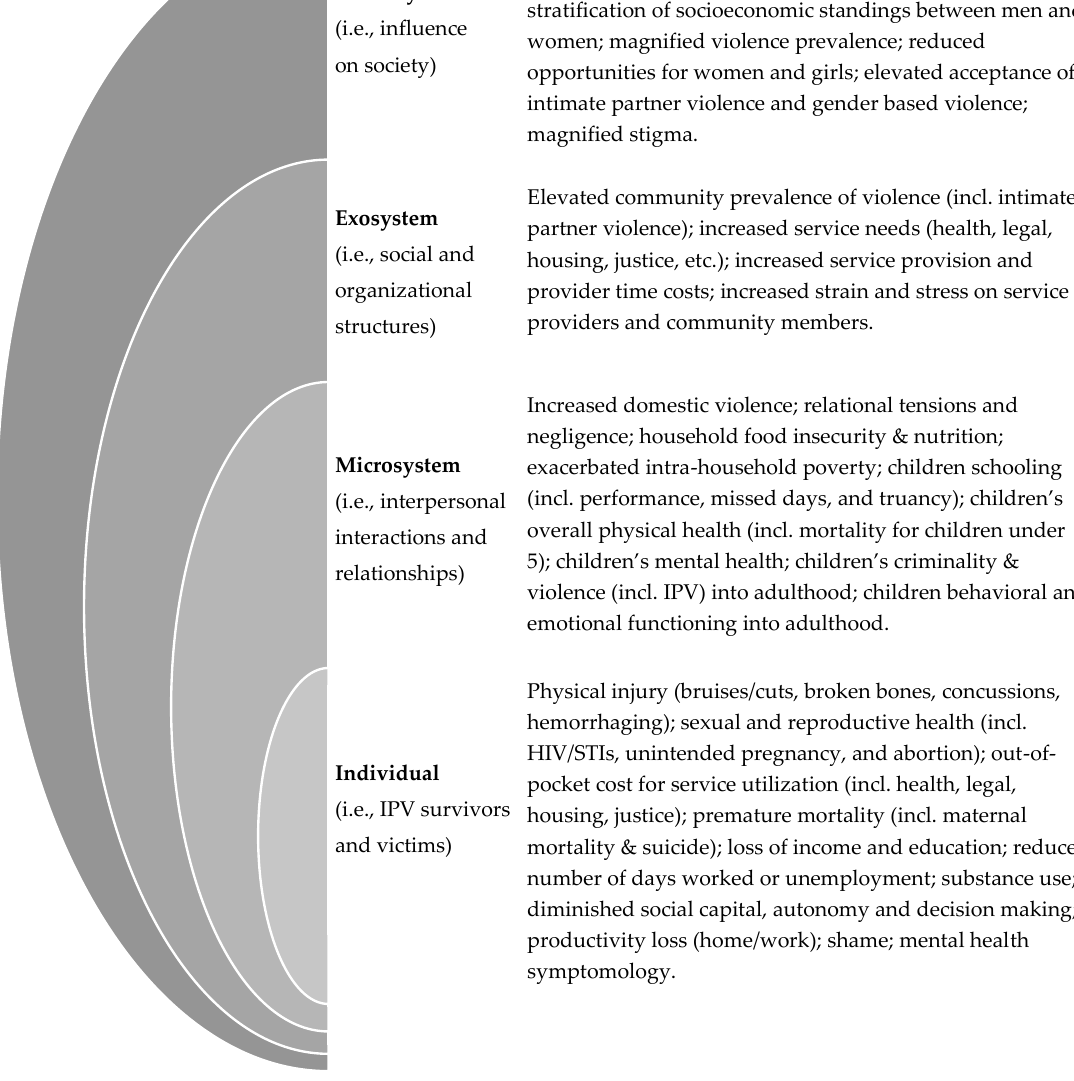
Figure 1. Impacts of intimate partner violence in humanitarian settings using an amended ecological